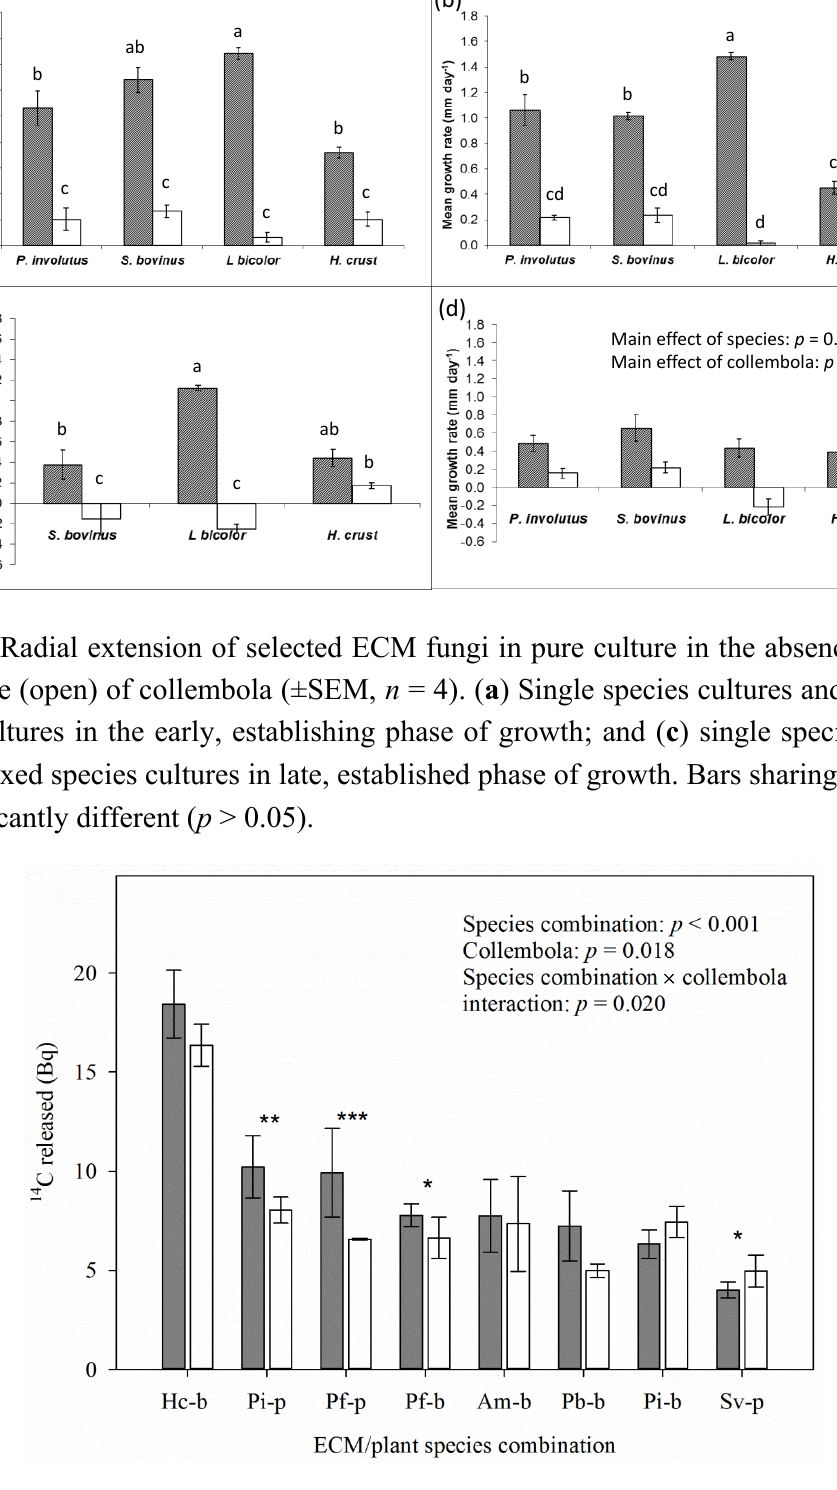
Figure 2. Mean efflux of 14 CO 2 from external mycelium during a three day pulse-chase of different ECM fungi and plant combinations in the absence (shaded) or presence (open) of collembola (back transformed means ± SEM). Species combinations: